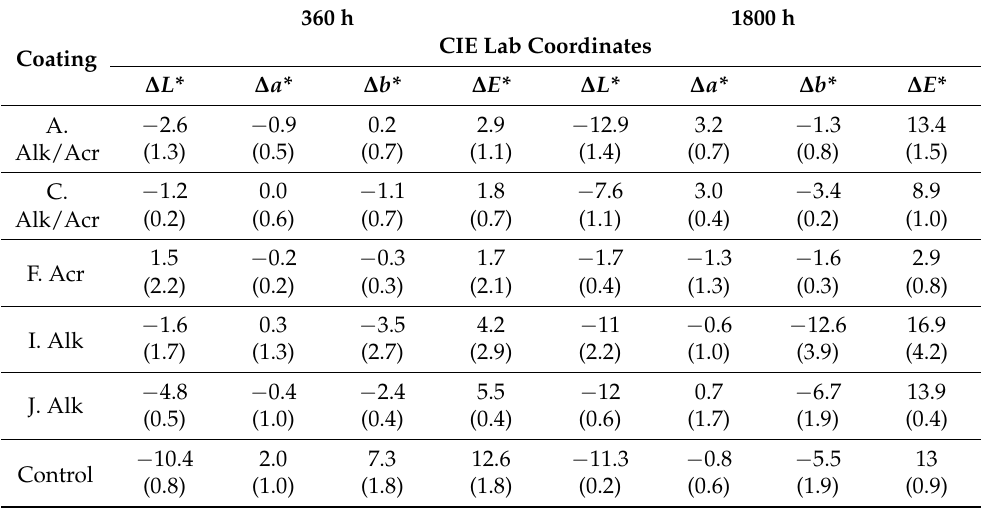
Table 4. Color change values of artificial weathered CLT samples. Mean and (standard